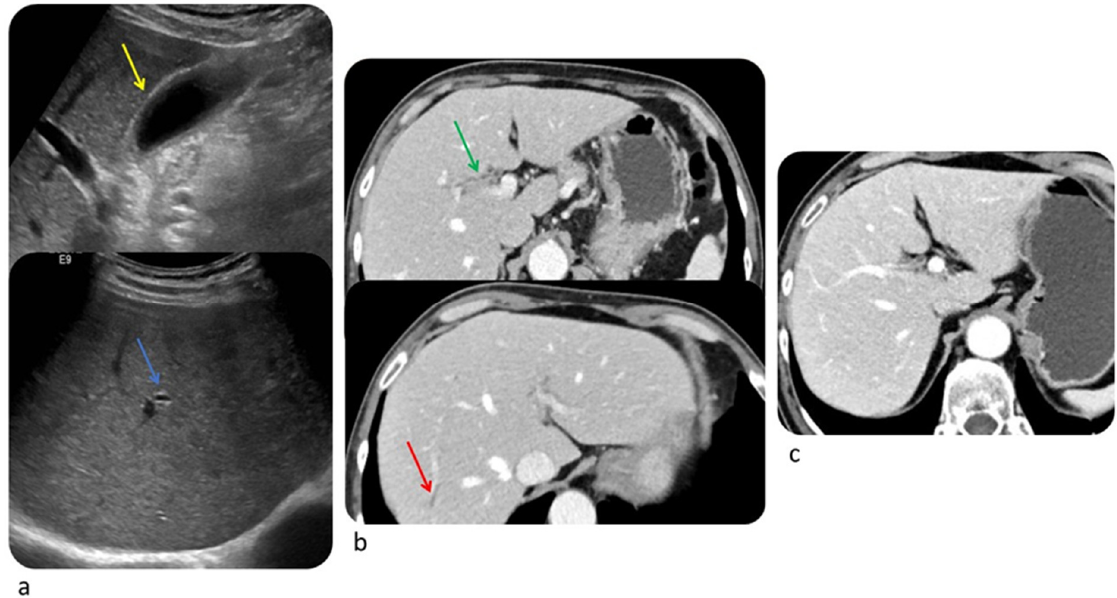
Figure 4. Immune related cholangitis in a 69-year-old female with metastatic melanoma treated with ipilimumab + pembrolizumab. Ultrasound shows layered gallbladder wall thickening likely representing gallbladder wall edema ( a , yellow arrow) and hyperechogenicity of periportal space ( a , blue arrows). Computed Tomography image shows mild wall thickness and contrast enhancement of the right hepatic duct ( b , green arrow) and mild dilated intrahepatic bile duct ( b , red arrow). Computed Tomography performed after steroid therapy demonstrates resolution ( c ). © Department of Radiology, Candiolo Cancer Institute—IRCCS. Turin.